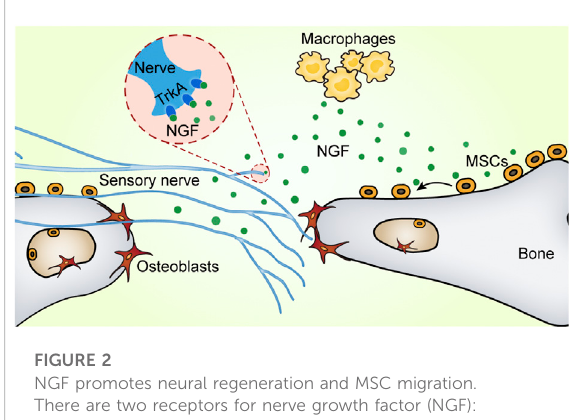
FIGURE 2 NGF promotes neural regeneration and MSC